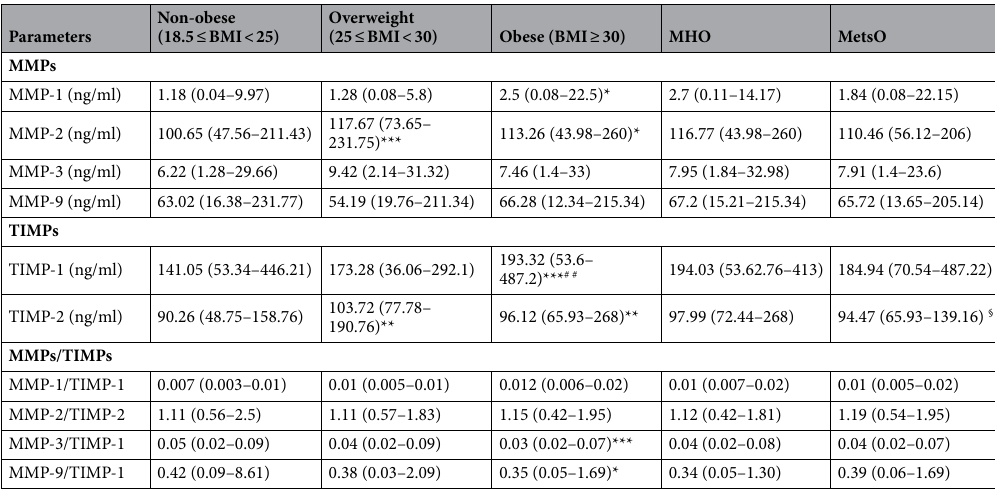
Table 2. MMPs and TIMPs levels of the study population. Data are presented as median (interquartile range). Statistical differences were obtained with adjusted values for age, gender, systolic blood pressure, LDL-C, TC and FG. *P < 0.05 vs non-obese. **P < 0.01 vs non-obese. ***P < 0.001 vs non-obese. # P < 0.05 vs overweight. ## P < 0.01 vs overweight. § P < 0.05 MetsO vs MHO. MetsO Metabolic syndrome obese, MHO Metabolic healthy obese, MMP matrix metalloproteinase, TIMP tissue inhibitors of